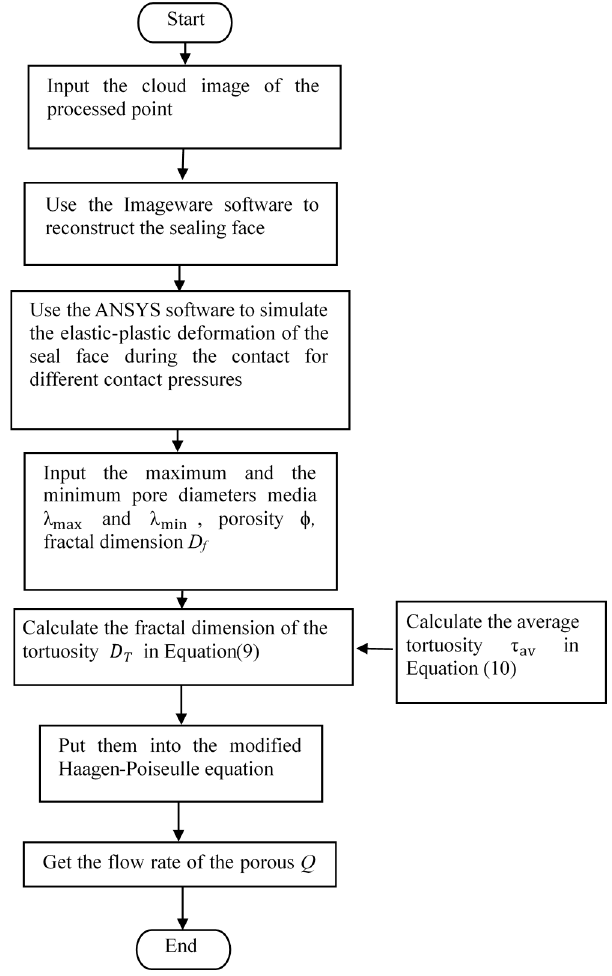
Figure 3. Flowchart for the calculation of the flow rate of the porous media.